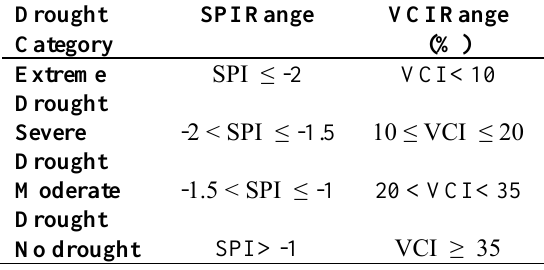
Table 1. Drought types, categories and its